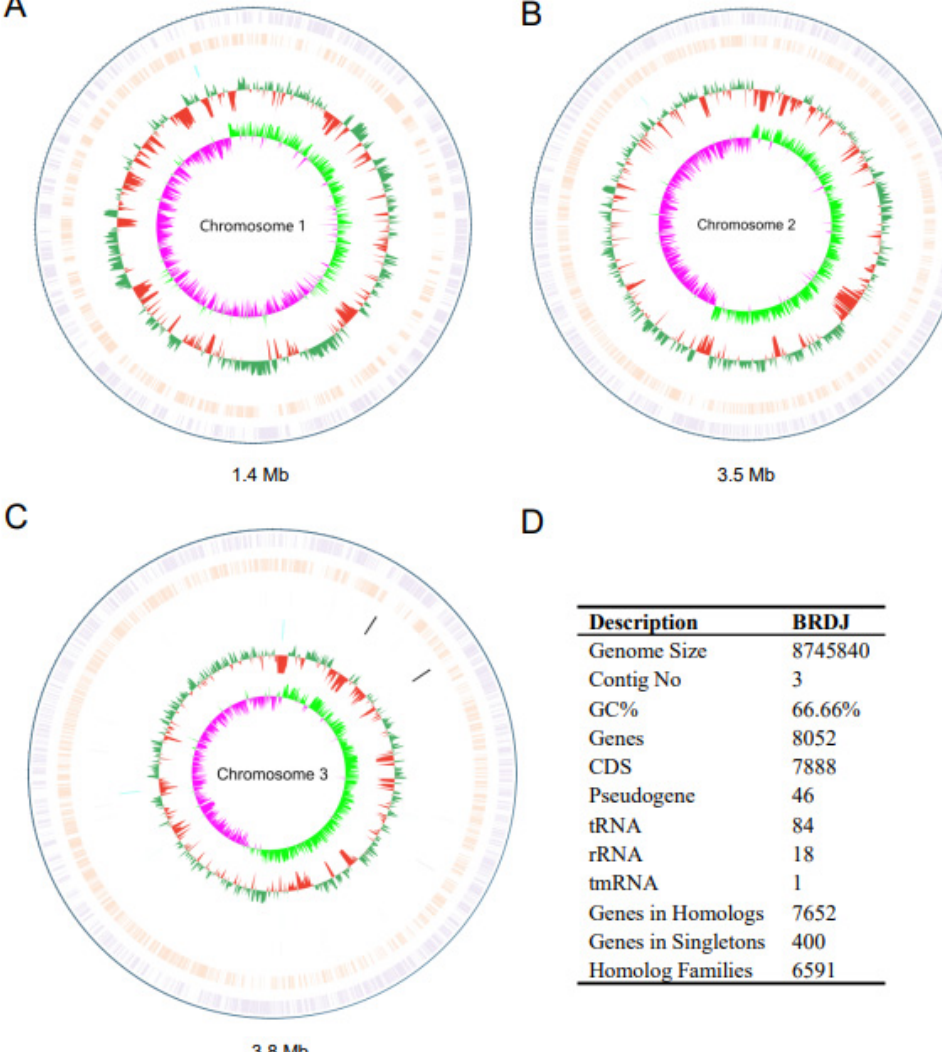
Figure 3. The overview of the BRDJ genome. ( A–C ) The circular map of BRDJ chromosomes. The tracks from outside to center represent the following features: (1) Forward CDS (pale purple); (2) Reverse CDS (apricot); (3) ncRNA (black); (4) %GC plot (green and red correspond to above and below average GC content respectively); (5) GC Skew [(G − C)/(G + C)] (light green and pink correspond to above and below average GC-skew respectively). All features were obtained from available annotations. ( D ) Table of the BRDJ genome properties.